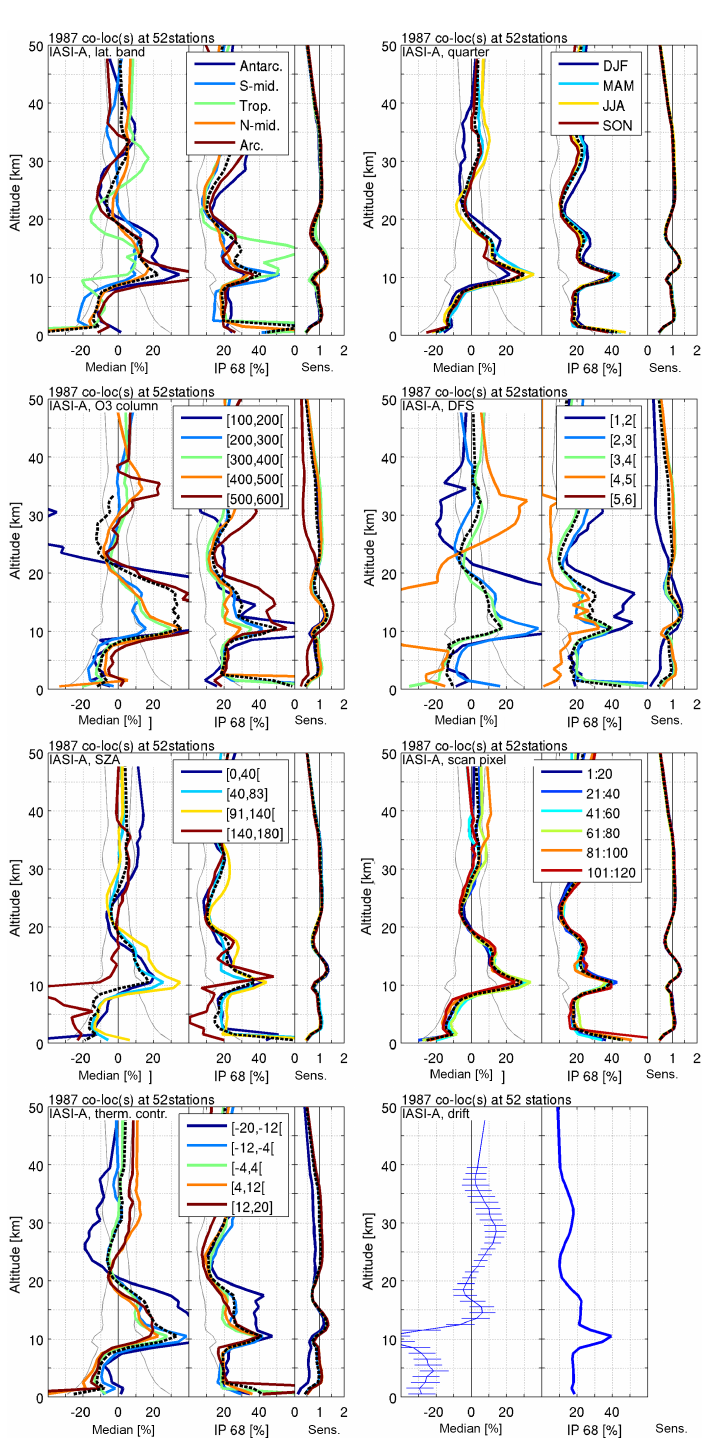
Figure 14. Median relative differences, 68% interpercentile spreads, and vertical sensitivities for comparison of FORLI v20151001 L2 IASI- A retrieved profiles with ground-based reference measurements (2008–2015). The same difference and information statistics are redistributed in each plot over several influence quantity ranges, with the influence quantities being (from left to right and top to bottom) latitude, quarter, total ozone column (DU), DFS, SZA, SPI, and TC. In the corresponding legend entries, open brackets are used to indicate that the last value is not included (i.e. values in the set go up to, but do not equal, the last value). The black dashed line shows the average of the coloured curves, while light grey lines indicate the satellite uncertainty provided in the product. The bottom right plot contains the corresponding relative decadal drift and 68% interpercentile spread. Two sigma error bars, resulting from a bootstrapping with 1000 samples, are added to the drift